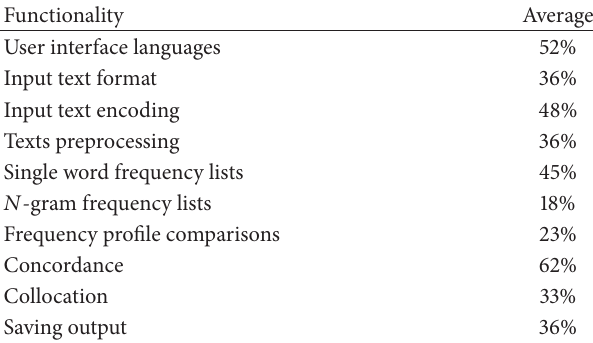
Table 3: Overall score for each evaluated heuristic. Heuristics